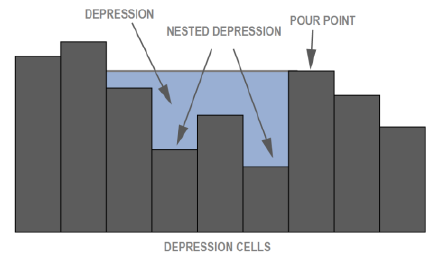
Figure 1. Terrain with the depressions (Bartak,